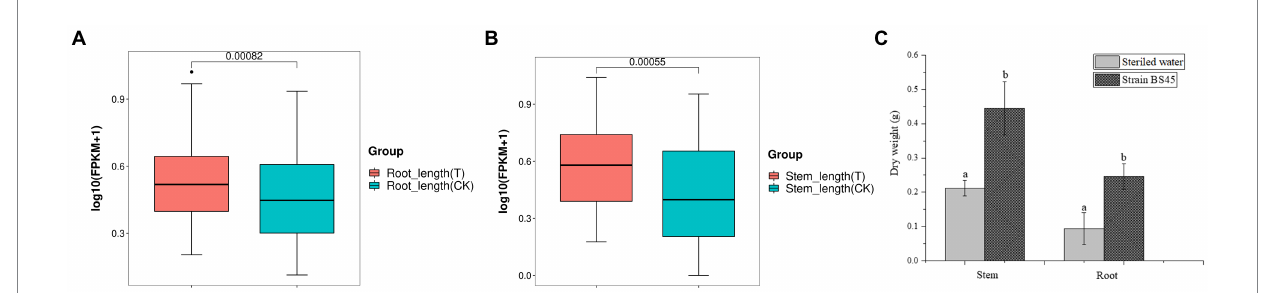
FIGURE 11 Effects of B. subtilis BS45 suspension on root length (A) , stem length (B) , and root and stem dry weights (C) of wheat. T: wheat seedlings inoculated with suspension of B. subtilis BS45; CK: wheat seedlings inoculated with sterile water. Three repeated experiments were performed, and the values are the means ± SD of the results from three independent experiments. Different letters indicate significant differences between the lines ( p < 0.05).